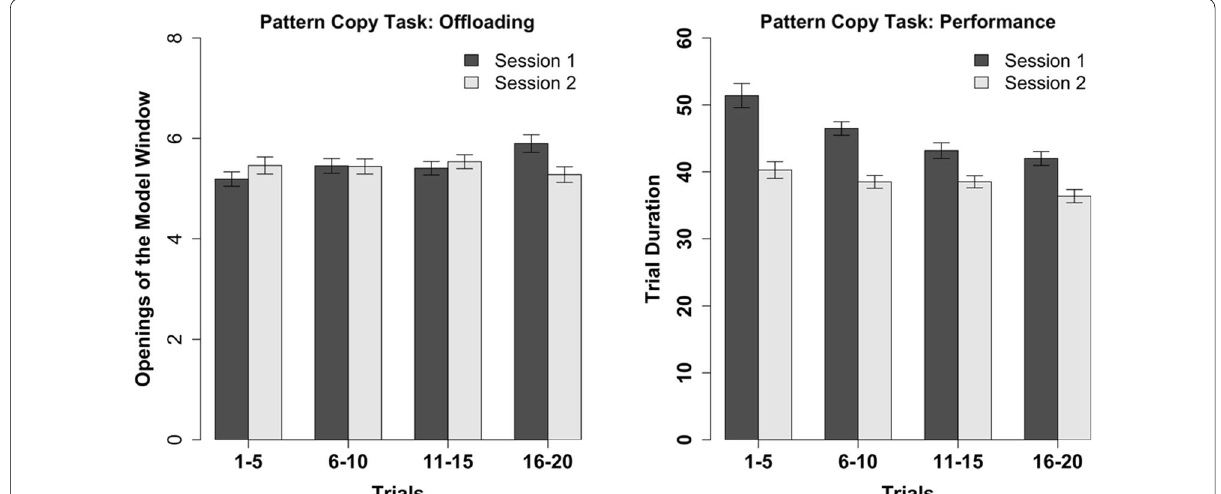
Fig. 7 Group-level analysis of offloading behavior (openings of the model window) and performance (trial duration) for the pattern copy task. Please note that the statistical analyses used the trial number as a continuous